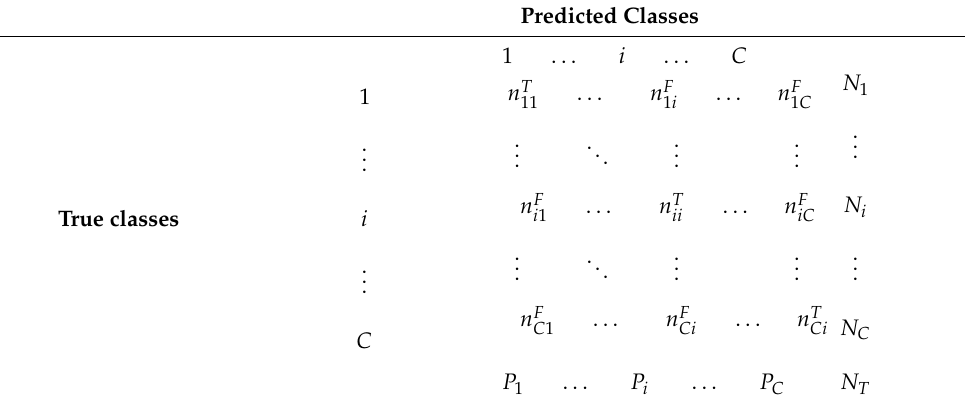
Predicted Classes 1 . . . i . . . C